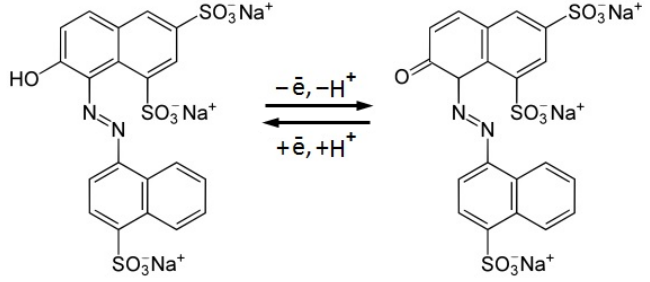
Figure 10. The mechanism of Ponceau 4R electrochemical transformation.